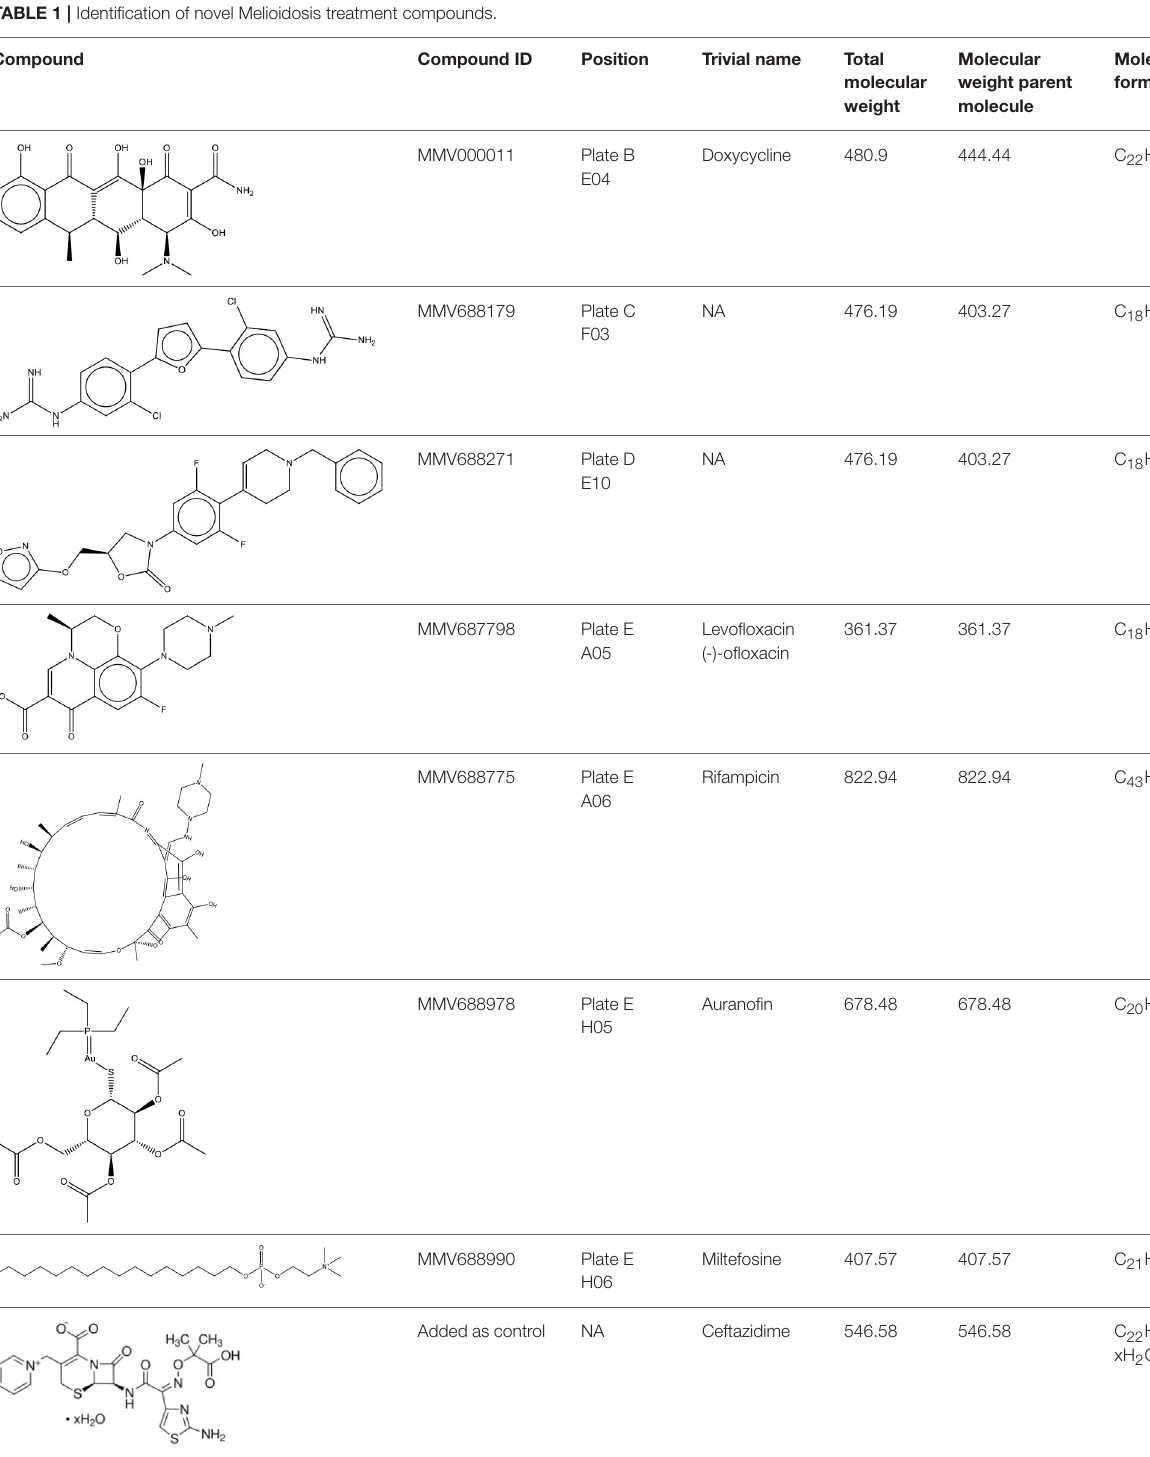
TABLE 1 | Identification of novel Melioidosis treatment